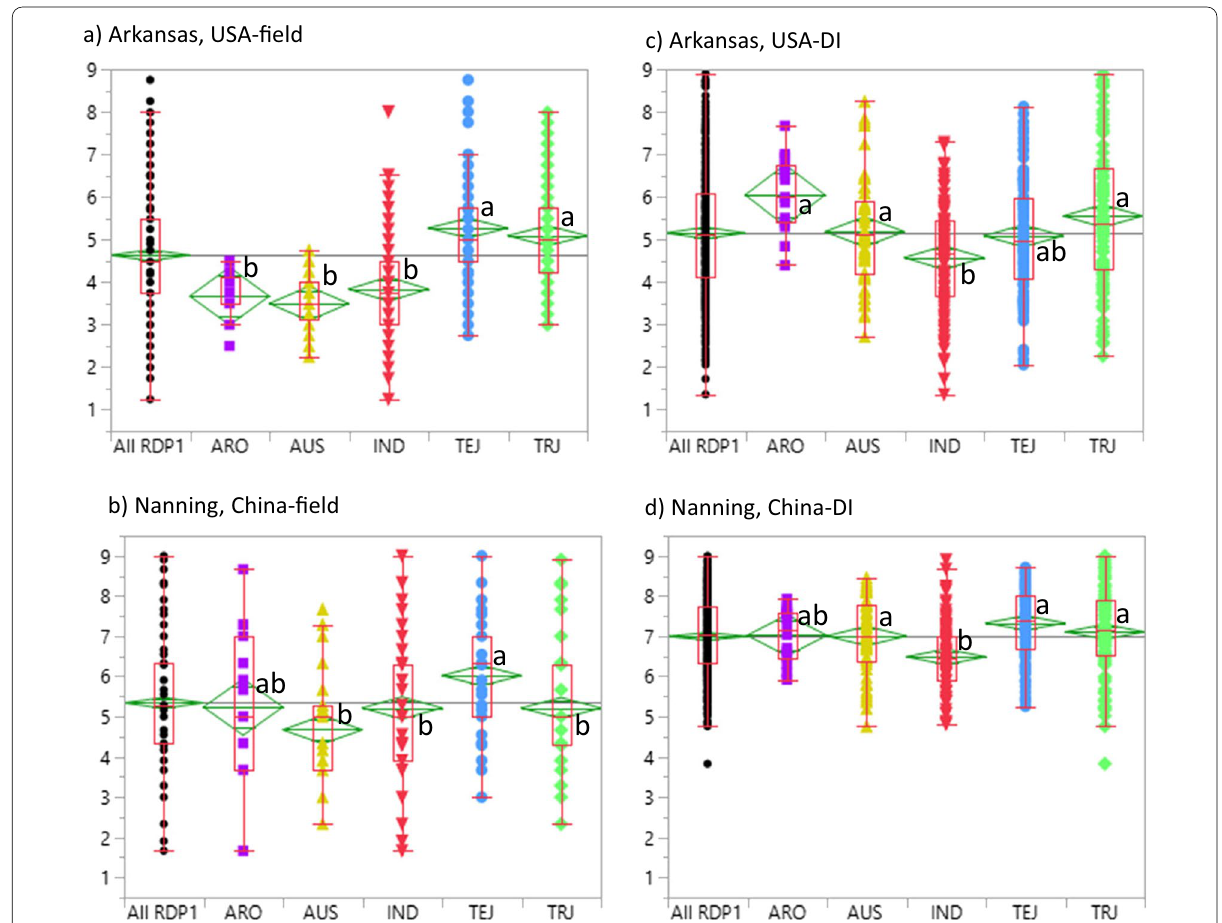
Fig. 1 Quantile plots comparing sheath blight disease ratings (0 no disease to 9 90% or more infected) between the Rice Diversity Panel 1 = = (All-RDP1) and the O. sativa subpopulations, aromatic (ARO), aus (AUS), indica (IND), temperate japonica (TEJ) and tropical japonica (TRJ). The ratings were from the field ( a , b ) and microchamber disease index (DI) ( c , d ) studies conducted in Arkansas, USA ( a , c ) and Nanning, China ( b , d ). Dots indicate full ranges of observed data; green diamonds indicate means se; lower and upper sides of red quantile boxes indicate the 25th and 75th ± percentiles, respectively; horizontal red lines in boxes are medians, vertical lines indicate the 5th and 95th percentiles. Different lowercase letters indicate differences between subpopulation means for that trait based on Tukey-Kramer multiple mean comparison tests and α =